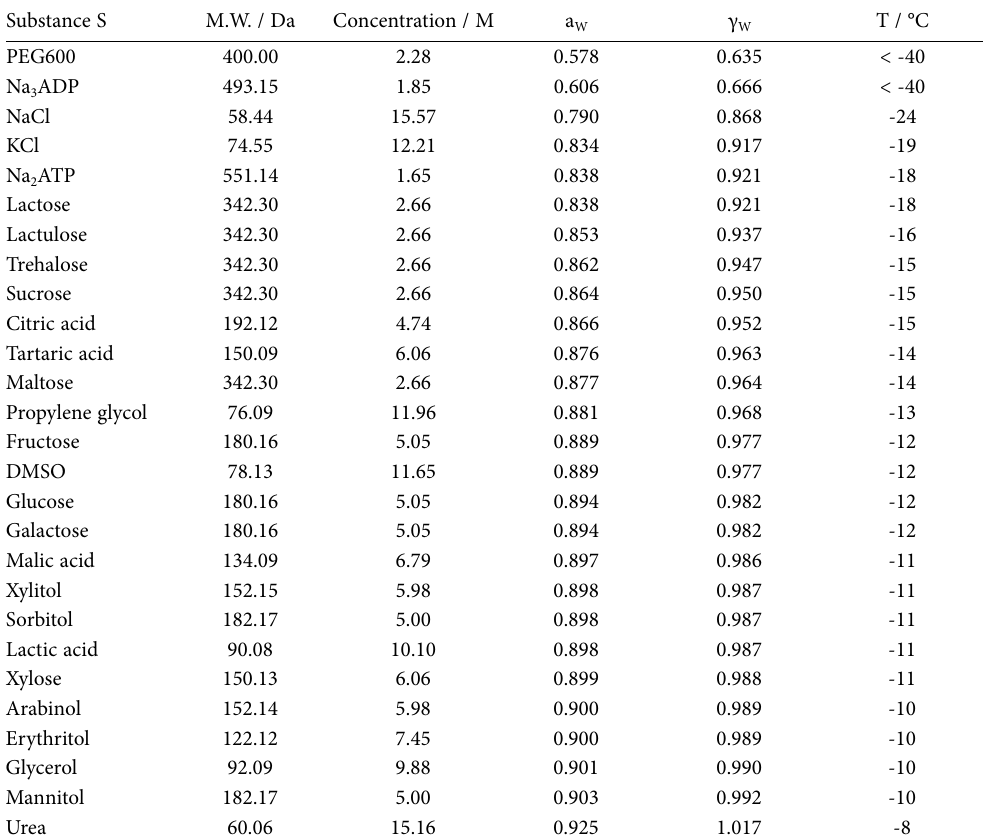
Table 10. Water activity a W , water activity coefficient γ W and equivalent equilibrium temperature T relative to supercooled water for a con- stant molar fraction X W = 0.91 of common solutes. One may convert water activities to equivalent osmotic pressures at T = 298.15 K throu- gh the relationship P(MPa) = -137.15×ln(a W